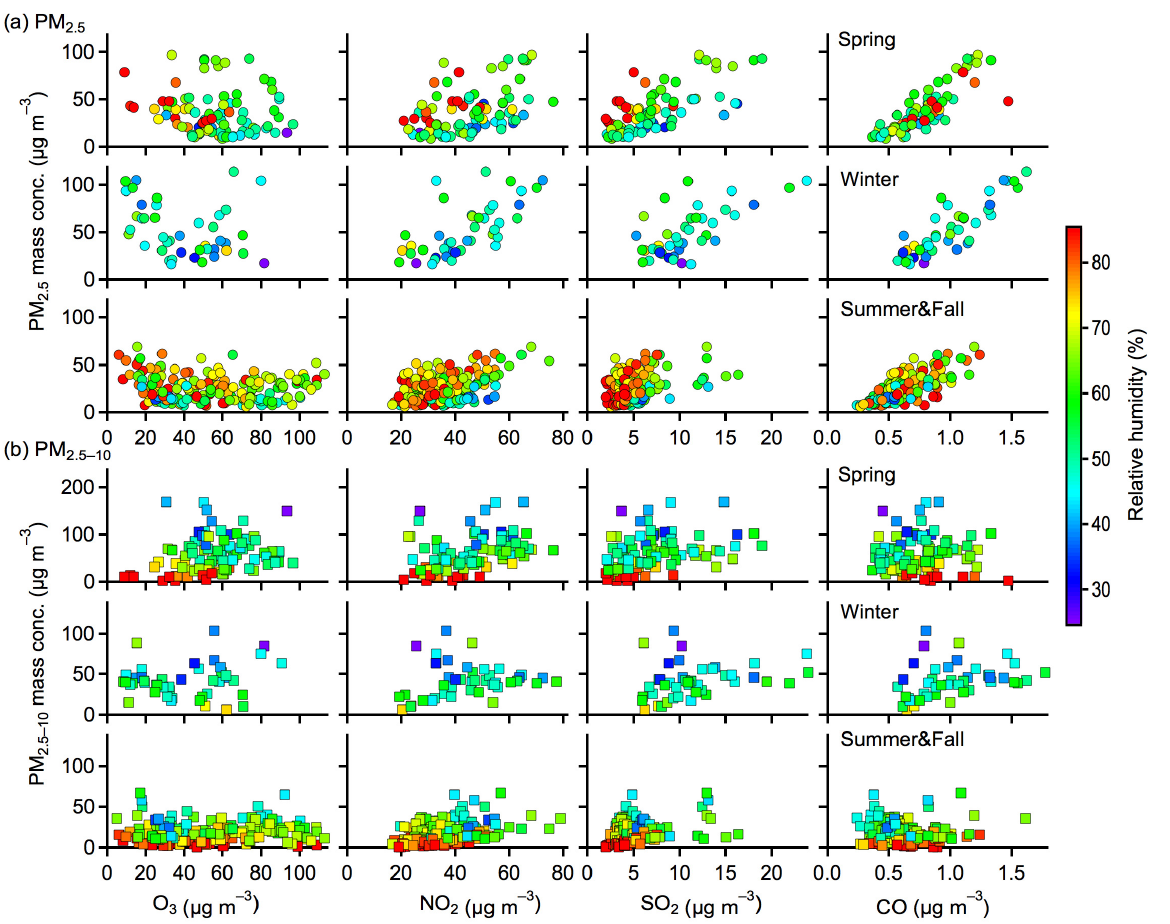
Figure 8. Correlations of the mass concentrations of ( a ) PM 2.5 and ( b ) PM 2.5–10 versus gaseous pollutants (O 3 , NO 2 , SO 2 , and CO). The markers were colored by the relative humidity in the air. Results presented here were averaged for daily data.